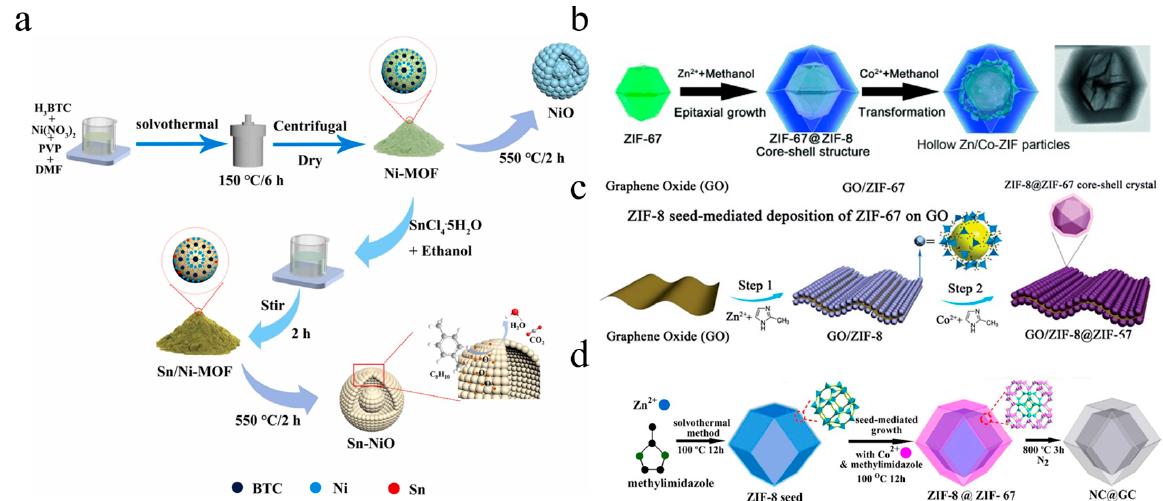
Figure 5. Schematic diagram of the stepwise synthesis of core–shell metal–organic framework hybrids. ( a ) Sn/Ni-MOF. Adapted with permission from Ref. [61], 2023, Elsevier; ( b ) Zn/Co bimetallic MOF. Adapted with permission from Ref. [62], 2023, John Wiley and Sons; ( c ) GO/ZIF-8@ZIF-67. Adapted with permission from Ref. [63]; ( d ) ZIF-8@ZIF-67. Adapted with permission from Ref. [64], 2023, American Chemical Society.